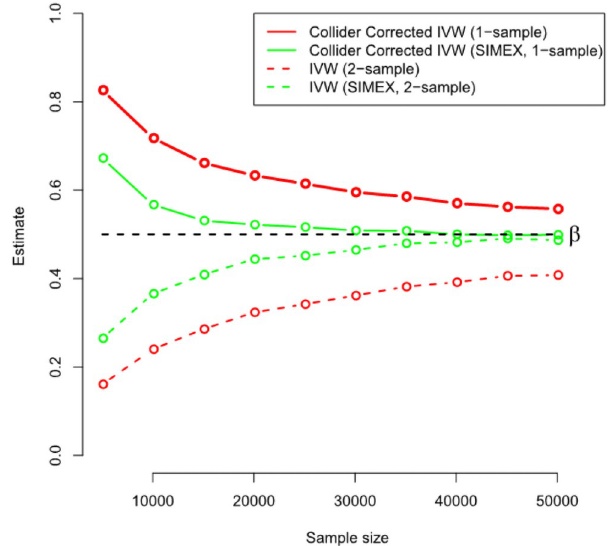
Fig 6. A comparison of the one sample Collider-Correction versus two-sample IVW approaches in terms of bias.